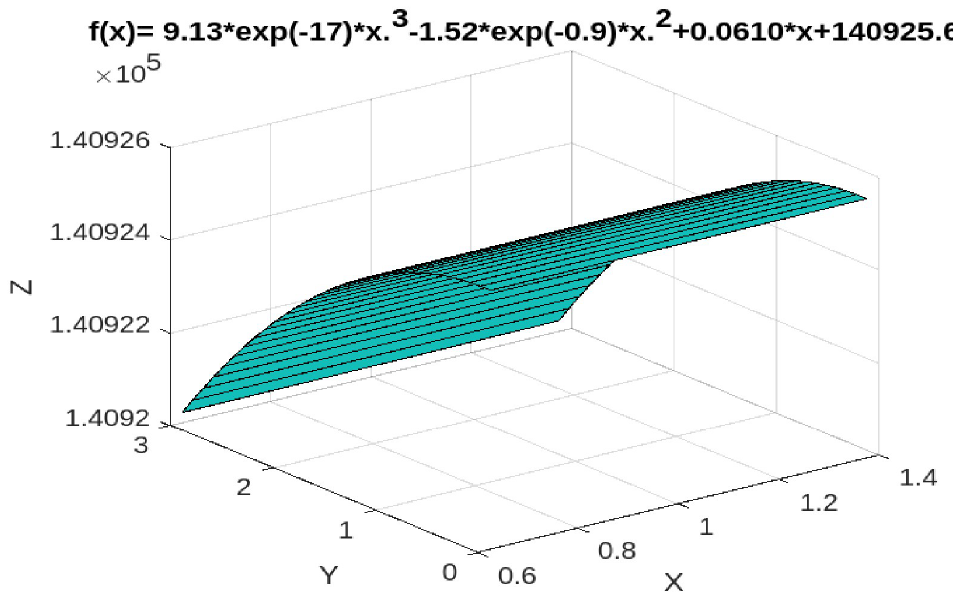
Fig 6. DTR-to-GDP threshold analyses, Taiwan, 1991–2020.